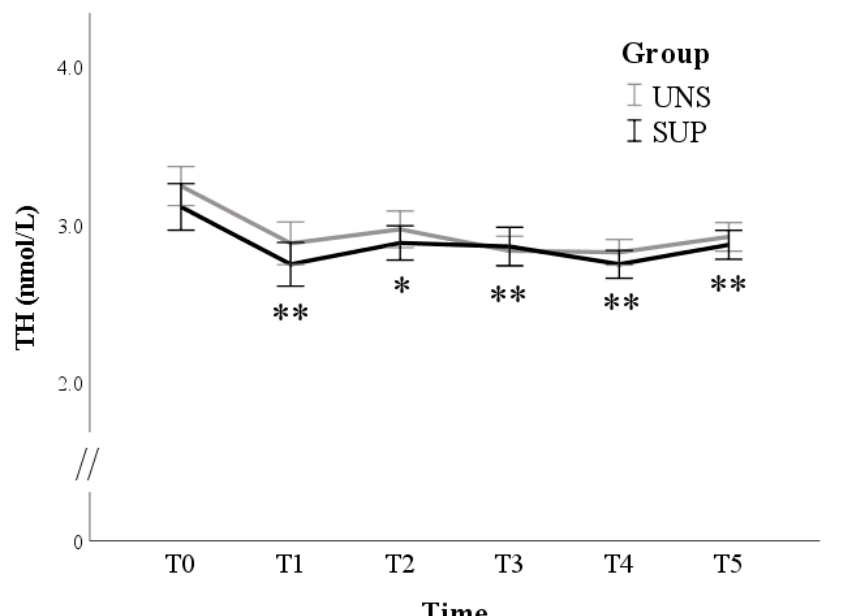
Figure 6. Means and standard errors of 3-3 ′ -5-triiodothyronine (TH) plasma concentrations in control (UNS) and supplemented (SUP) lactating sheep monitored before the administration of supplementation (T0), and then every 10 days until dry off (T1–T5). * p < 0.05, ** p < 0.01: each time vs. T0 in SUP and UNS.